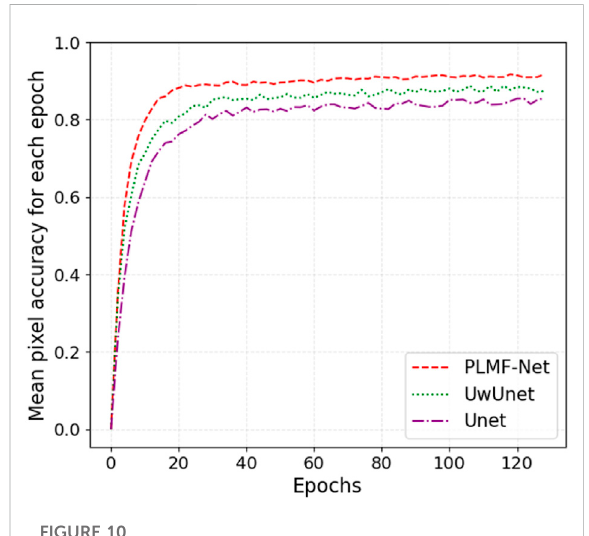
FIGURE 10 Mean pixel-accuracy comparison among different methods. The red dashed line, green dotted line, and purple dashed dotted lines represent the Unet, UwUnet, and PLMFNet models,